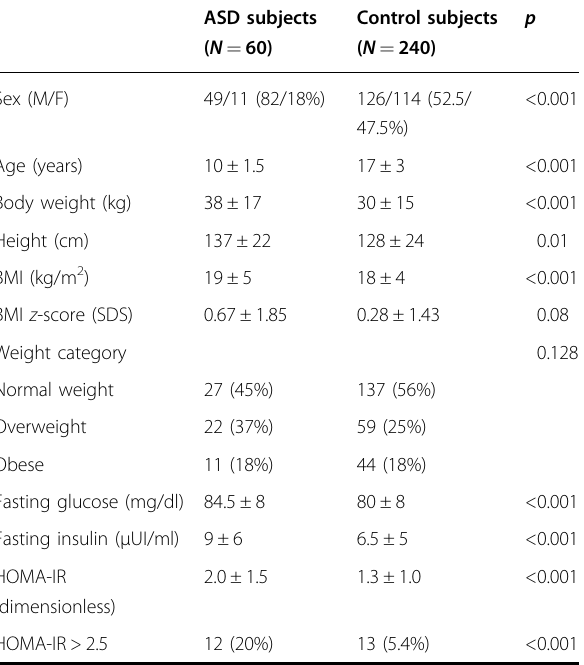
Table 1 Baseline characteristics of patients and controls. Table 2 Mean values of serum metabolites in